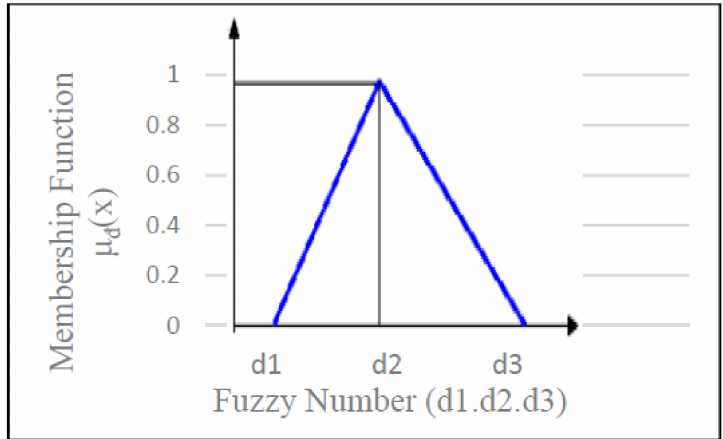
Figure 7. Fuzzy triangular membership